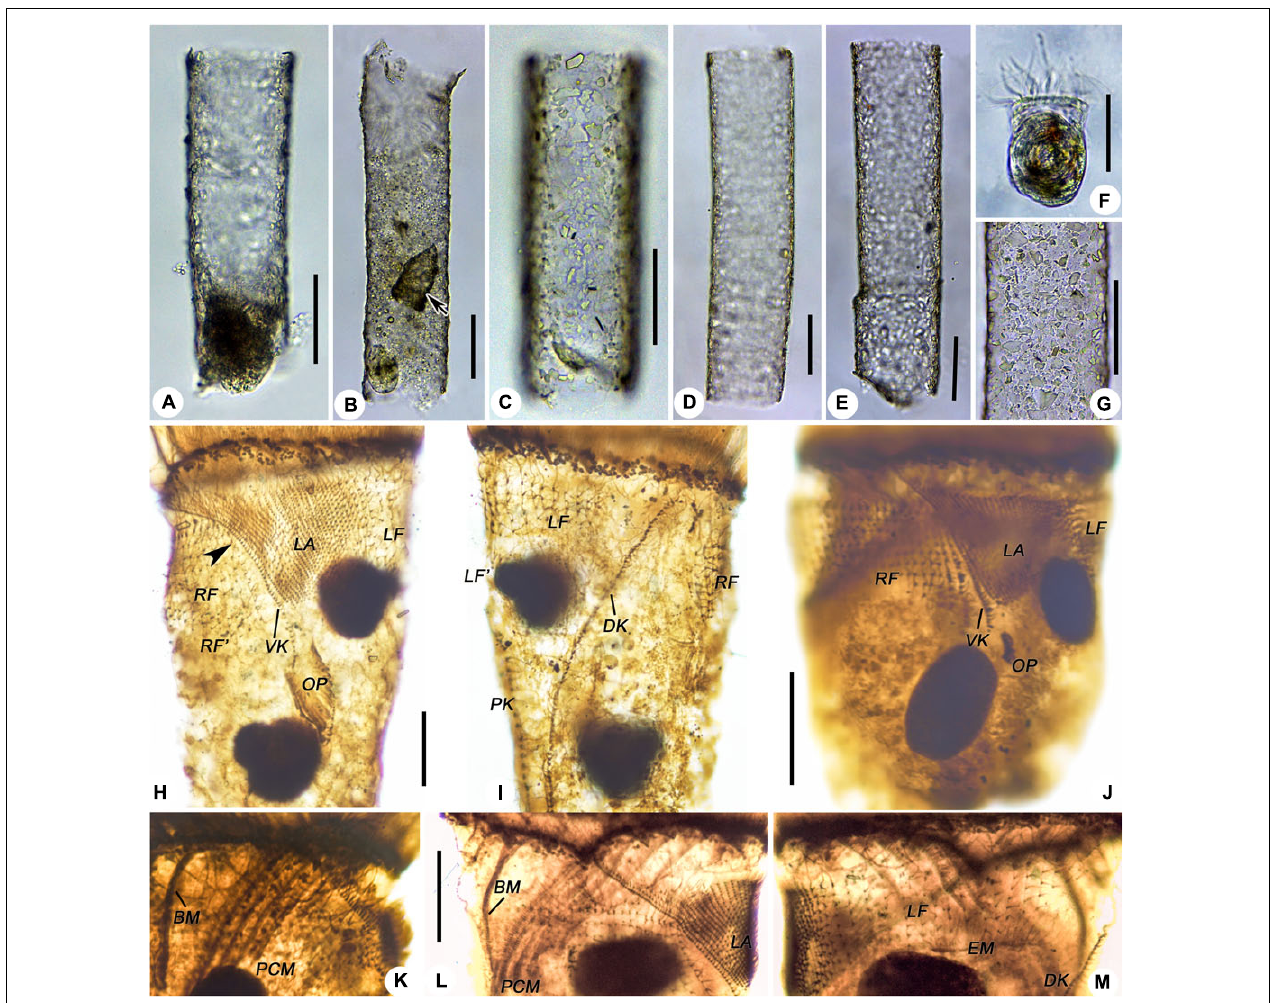
FIGURE 6 | Leprotintinnus simplex from life (A–G) and after protargol staining (H–M) . (A) A representative specimen. (B–E) Showing the variability of loricae shape and size, the arrow denotes a predated Tintinnopsis sp. (F) Cell proper out of the lorica. (G) Lorica wall with numerous mineral particles. (H,I) Ventral and dorsal views of the same specimen, showing the ciliary pattern, arrowhead indicates the dikinetids at the anterior end of the right ciliary field. (J) Ventral view of an early divider, showing the location of the oral primordium and the posterior end of the VK. (K) Prolonged membranelles and buccal membranelle. (L) Lateral view showing the right ciliary filed and the anterior position of the VK; M, Left ciliary field, dorsal kinety, and endoral membranelle. BM, buccal membranelle; DK, dorsal kinety; EM, endoral membranelle; LA, lateral ciliary field; LF, LF (cid:48) , proter’s and opisthe’s left ciliary fields; OP, oral primordium; PCM, prolonged collar membranelles; RF, RF (cid:48) , proter’s and opisthe’s right ciliary field; VK, ventral kinety. Scale bars: 50 µ m (A–G) , 15 µ m (H–M)